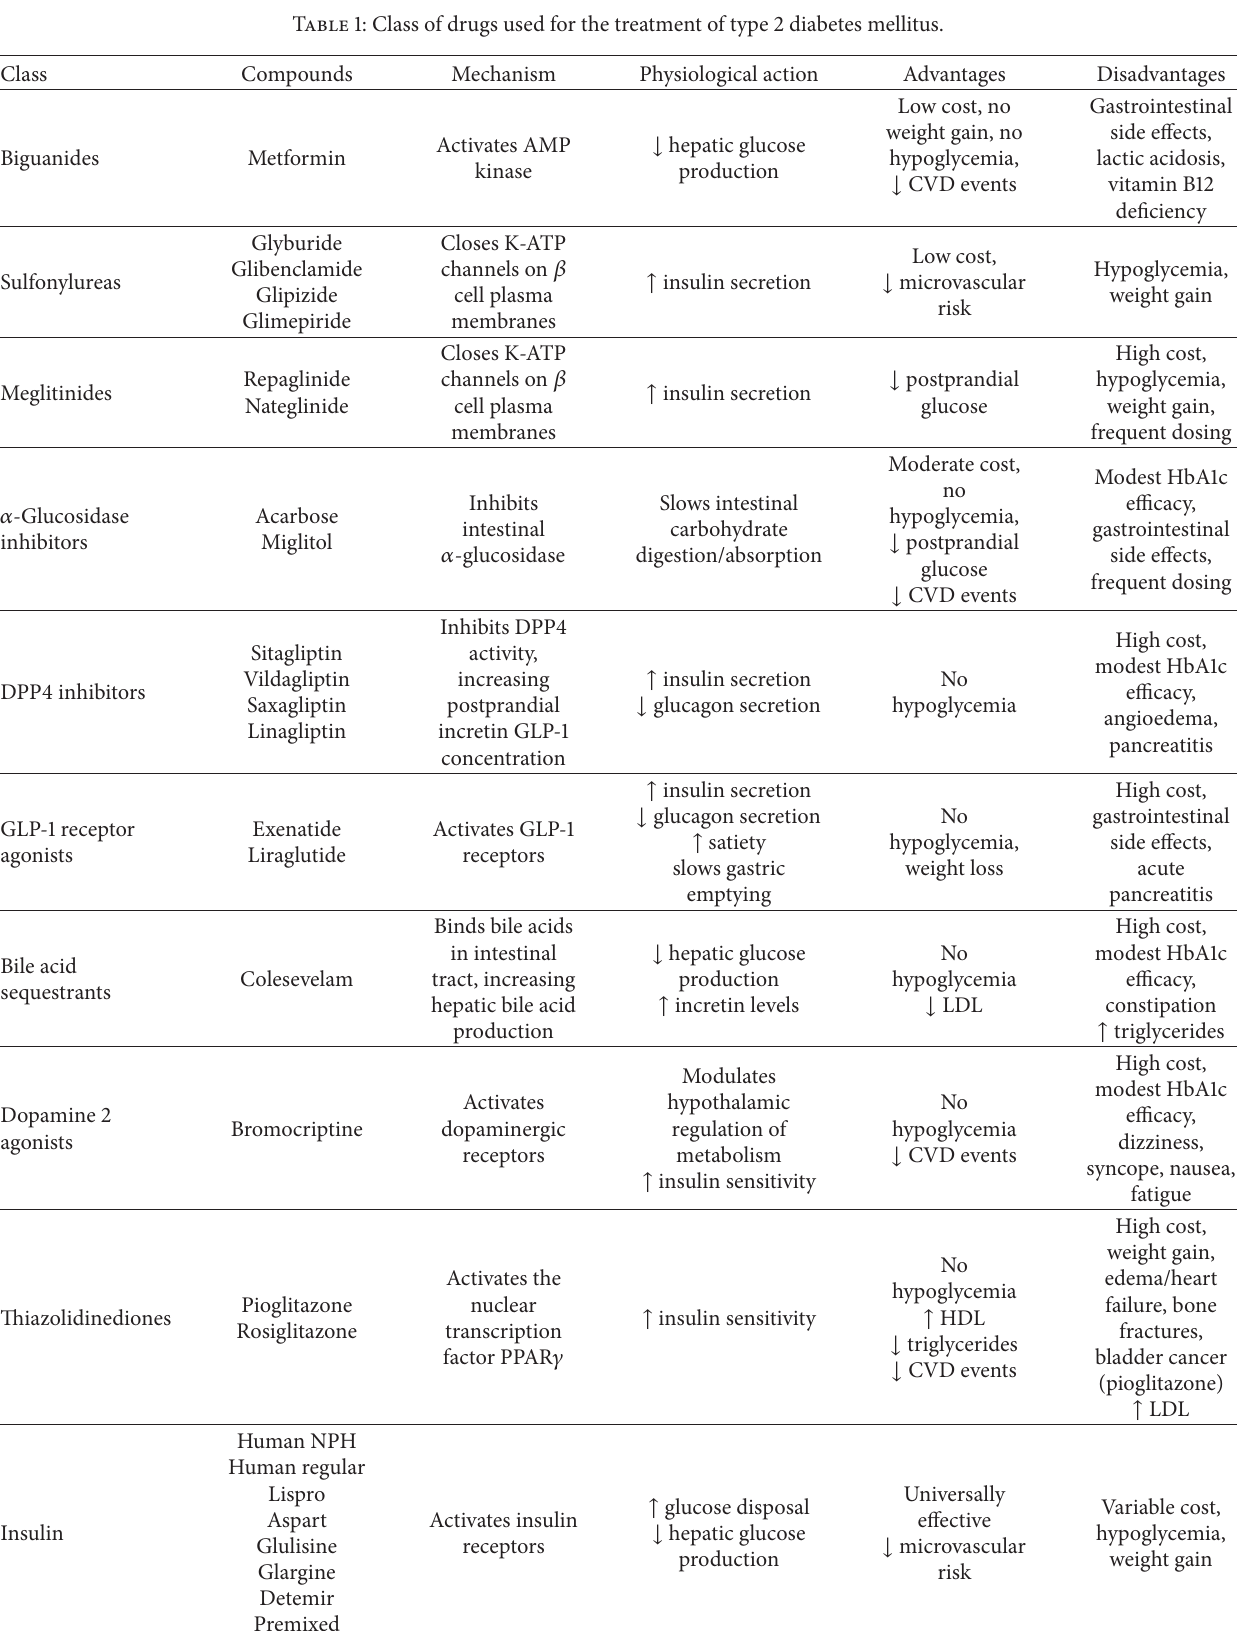
Table 1: Class of drugs used for the treatment of type 2 diabetes